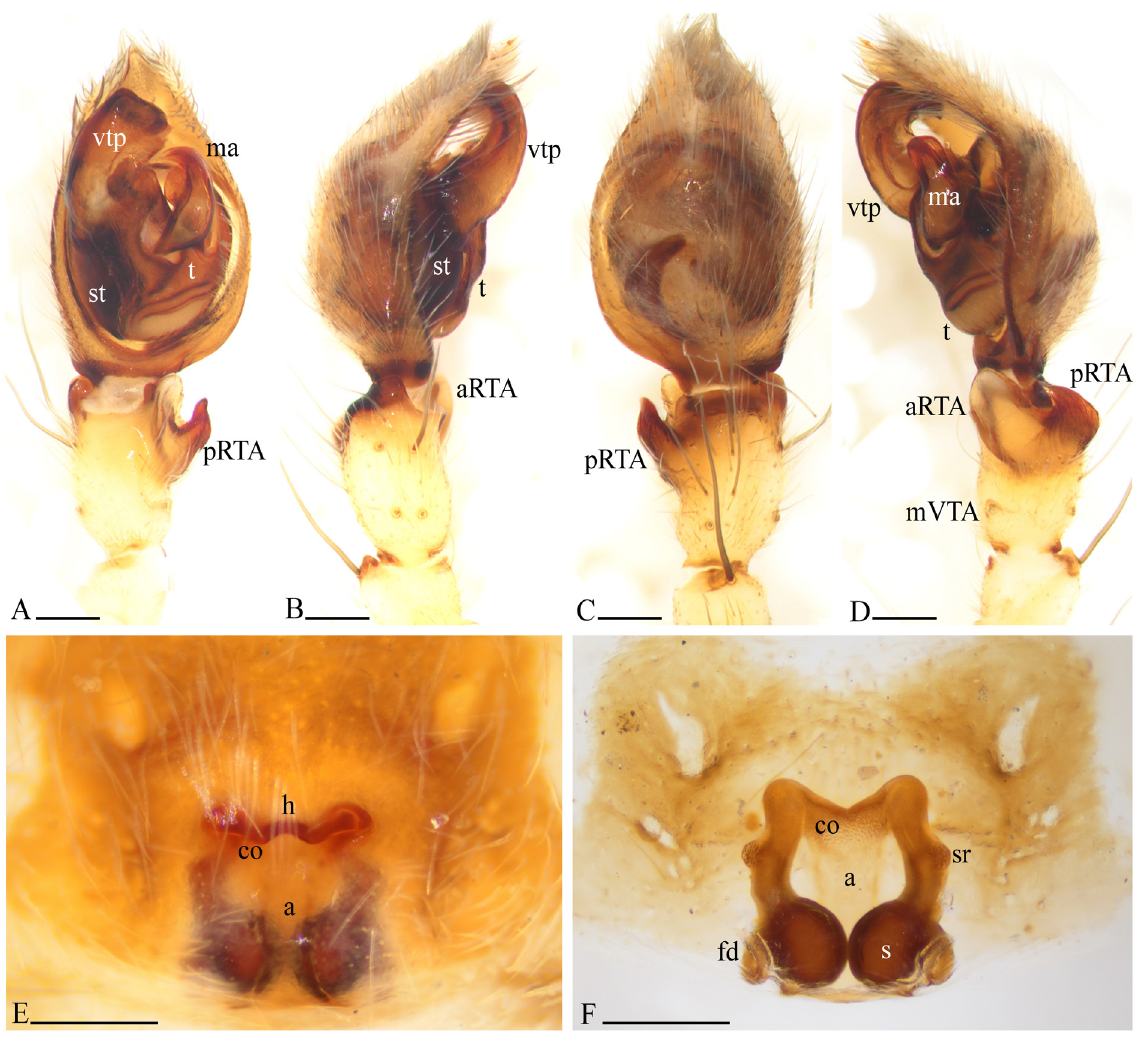
Fig. 29. Anyphaena rebecae sp. nov. A–D . Paratype, ♂ (CNAN-T01568). E . Holotype, ♀ (CNAN-T01536). F . Paratype, ♀ (CNAN-T01569). A . Pedipalp, ventral view. B . Pedipalp, prolateral view. C . Pedipalp, dorsal view. D . Pedipalp, retrolateral view. E . Epigynum, ventral view. F . Epigynum, dorsal view. Scale bars: 0.2